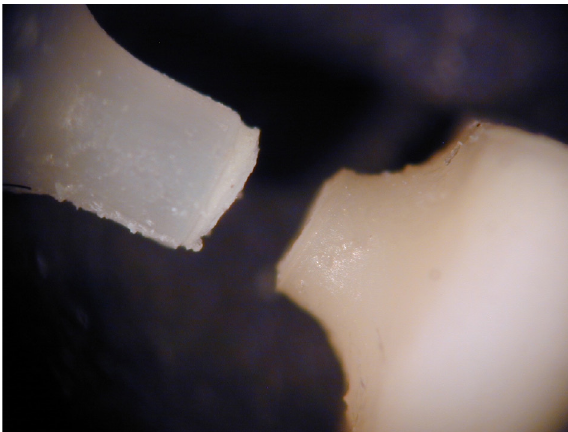
Figure 3- Apparent failure within dentin near the adhesive interface as seen under light microscopy